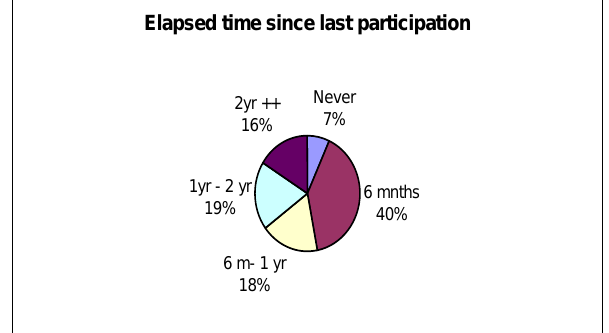
Figure 1: Elapsed time since last participation in teambuilding